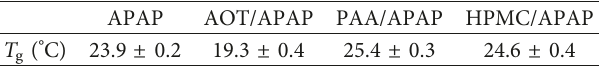
Table 2: Glass transition temperature ( T